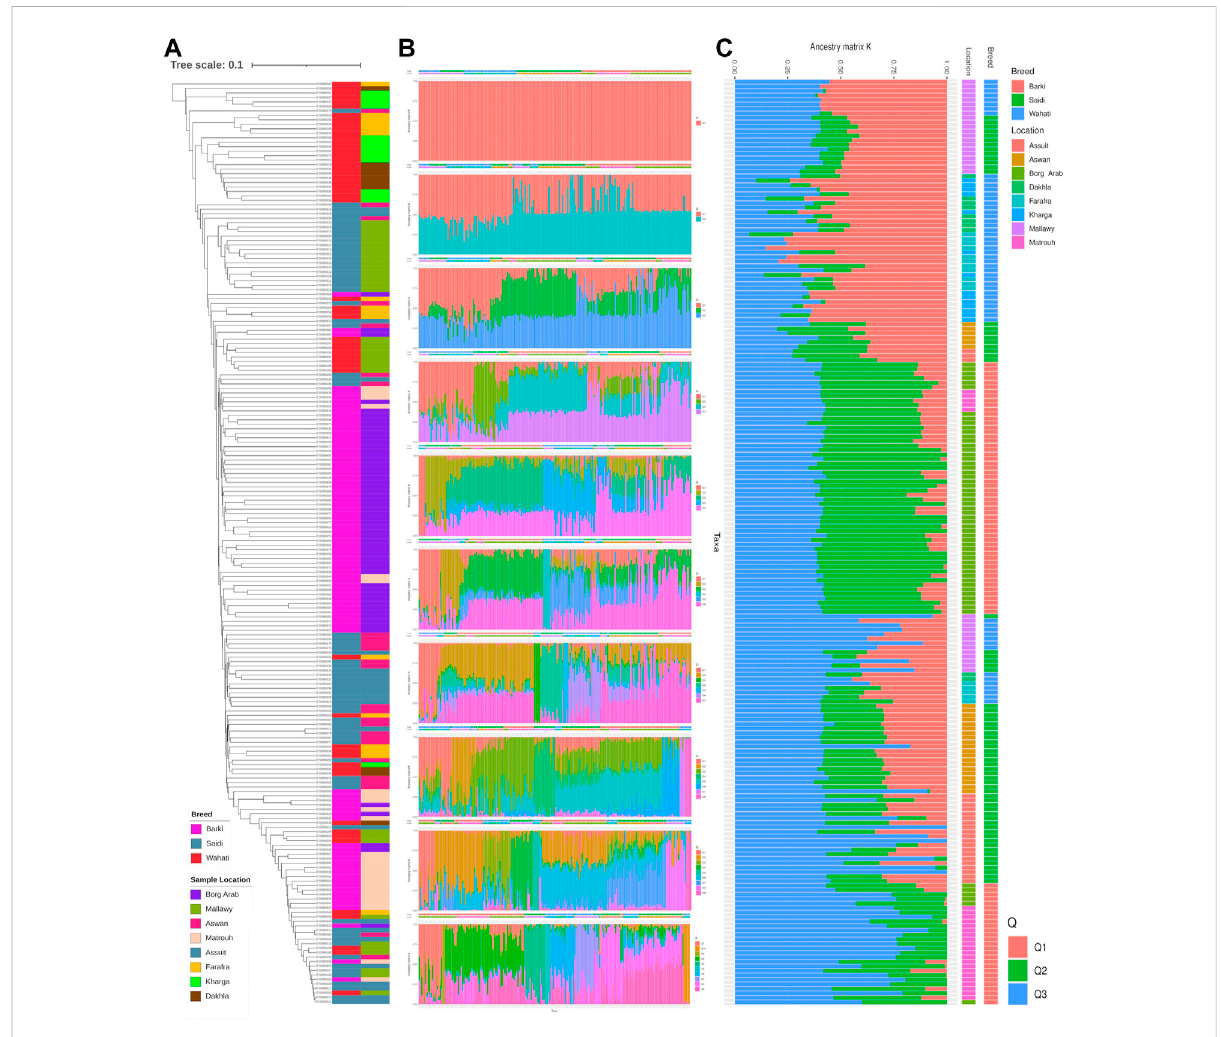
FIGURE 2 The diversity analysisofthe studied sheeppopulation. (A) Phylogenetic tree ofthe sheeppopulation studied, colored bybreed and location. (B) Population structurebasedontheoptimalnumberofclusters(k-means)solutionsforK=1 – 10. (C) Population structurebasedontheoptimalKof3.